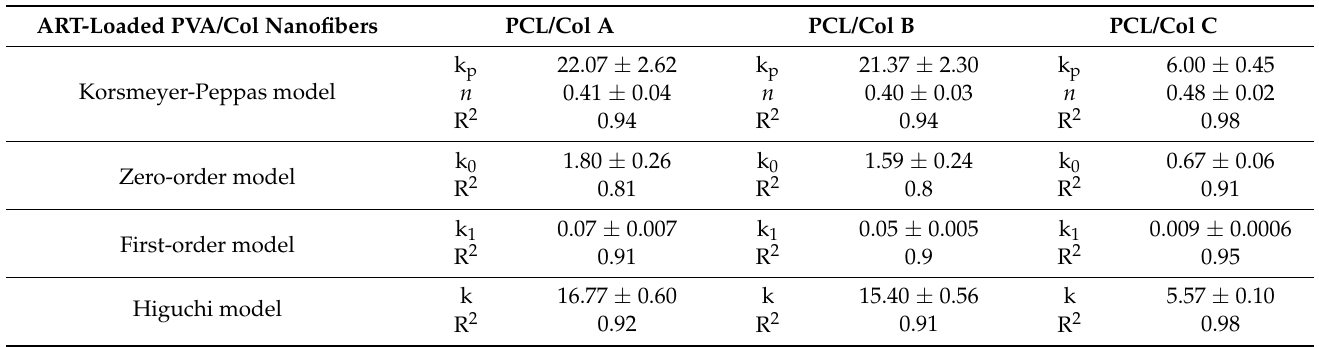
Table 2. The release models of ART-loaded PCL/Col nanofibers with different polymer ratios. ART-Loaded PVA/Col